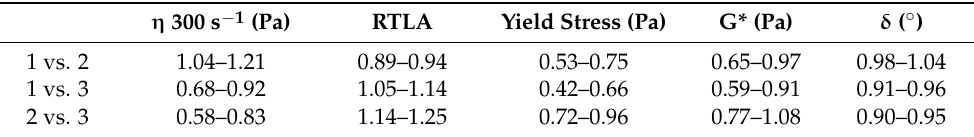
Table 3. The 90% confidence intervals of the rheological parameters of three batches of 0.025% w / w capsaicin emulsions: viscosity ( η ), relative thixotropic loop area (RTLA), complex modulus (G*), and phase angle of delta tangent ( δ ).